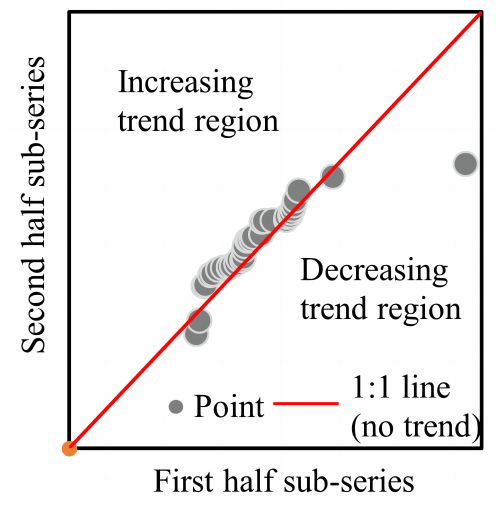
Figure 2. Example of an ITA application over a time